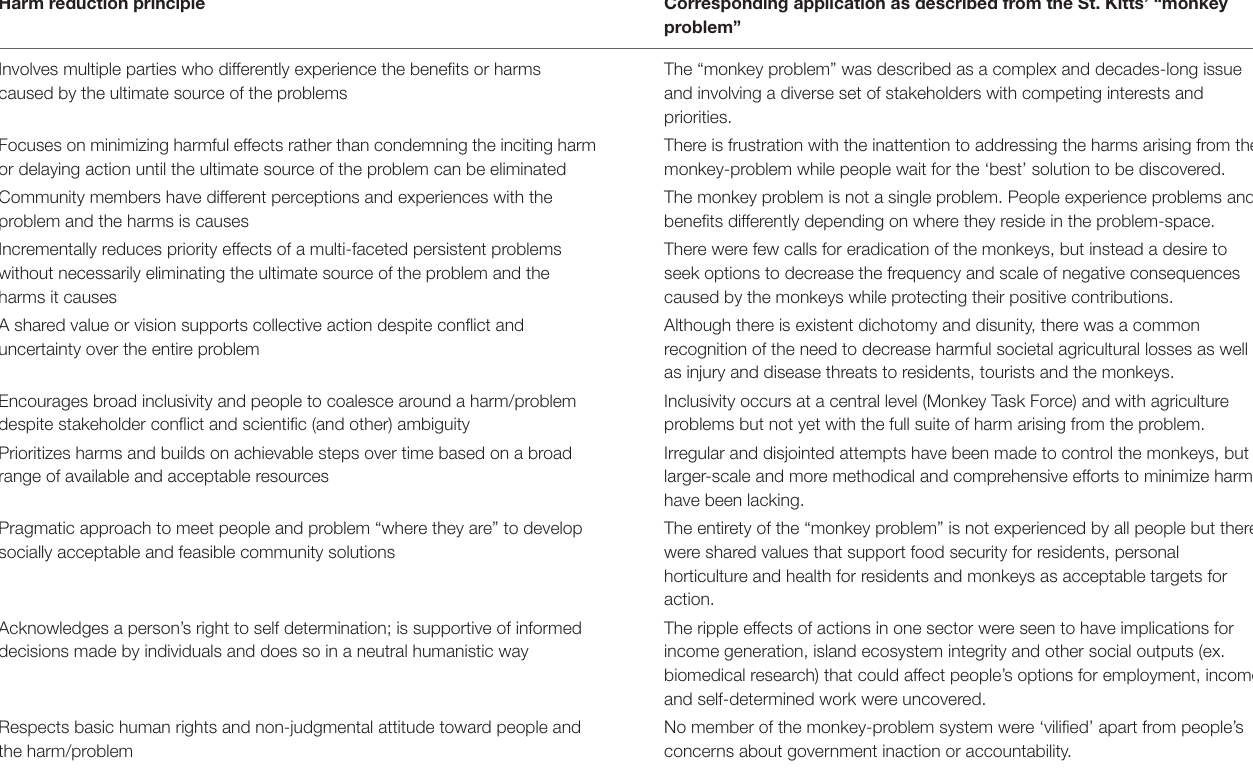
TABLE 7 | Alignment of the St. Kitts’ “monkey problem” with harm reduction